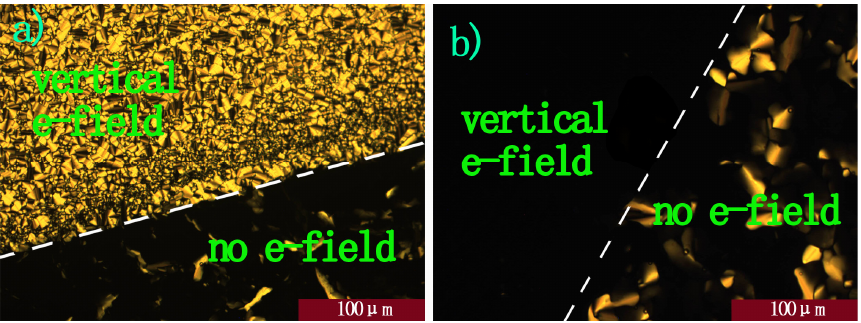
Figure 6. ( a ) and ( b ) POM image under cross-polarizers with vertical E-field; ( a ) DC; ( b ) AC, 50 Hz; sandwiched by glass plates with patterned ITO electrodes (15 μ m spacer) under an applied electric field of 6 V μ m − 1 . The dashed lines represent the borders of the E-field operating and non-operating